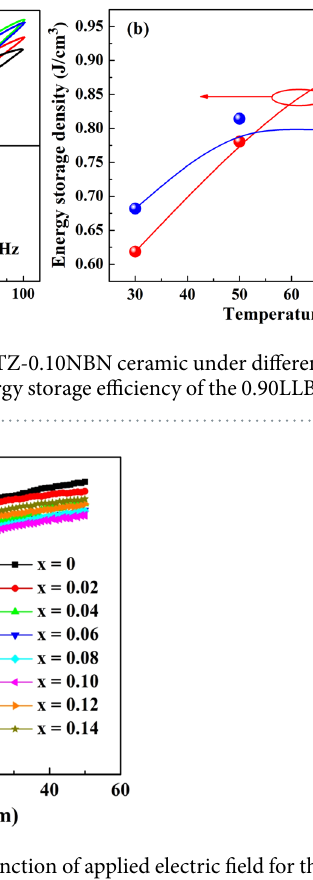
measurement, the sintered samples were polished to obtain smooth and parallel surfaces. Then, a silver paste was painted and fired at 800 °C for 20 min to form the electrode. The temperature dependent dielectric constant and dielectric loss were measured using the LCR meter (3532–50, Hioki, Ueda, Japan) in the frequency range from 1 kHz to 1 MHz. The P-E hysteresis loops and the leakage current density were characterized by a ferroelectric test system (Premier II, Radiant, USA) and the samples were immersed in silicone oil to avoid surface flashover in the process.